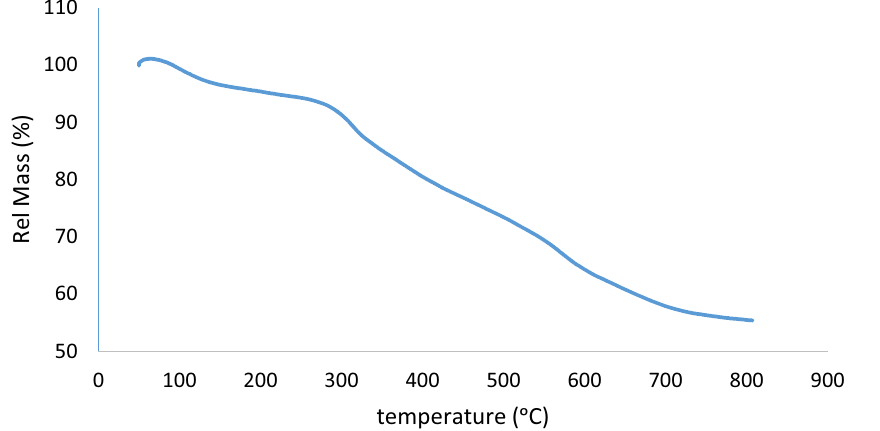
Figure 3. TGA analysis of the MCM-41-APS-PMDA-NHSO 3 H materials ( 1 ).